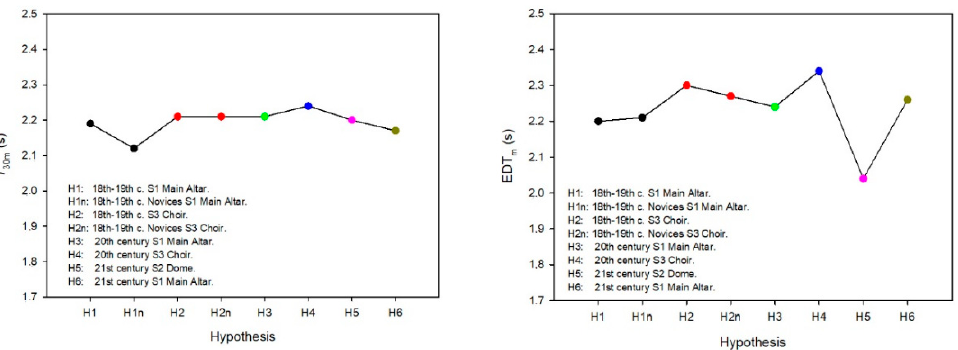
Figure 10. Acoustic parameter evolution T